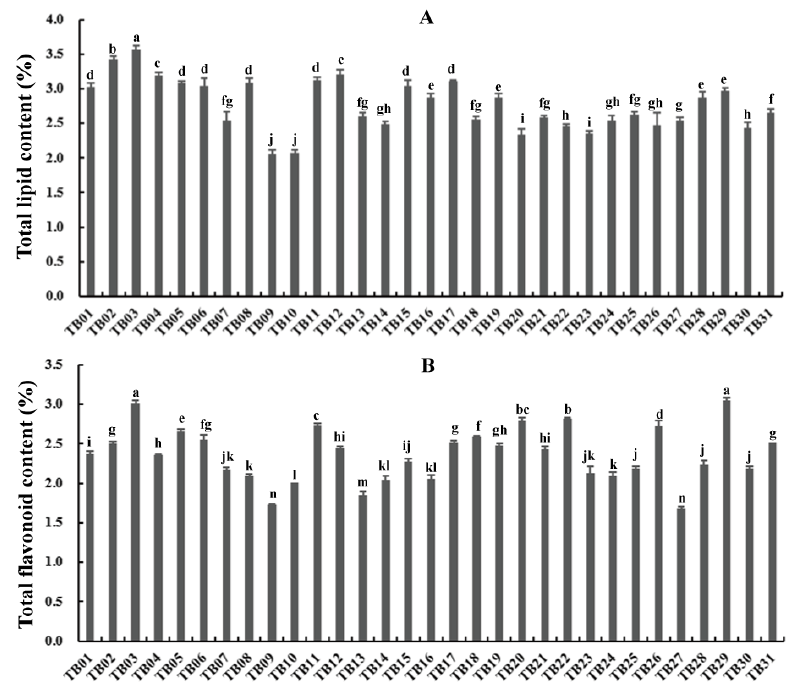
Figure 1. The total lipid ( A ) and total flavonoid ( B ) content of different Tartary buckwheat accessions. Different letters correspond to significant differences among different Tartary buckwheat accessions from the ANOVA with Duncan’s multiple range test ( p < 0.05).